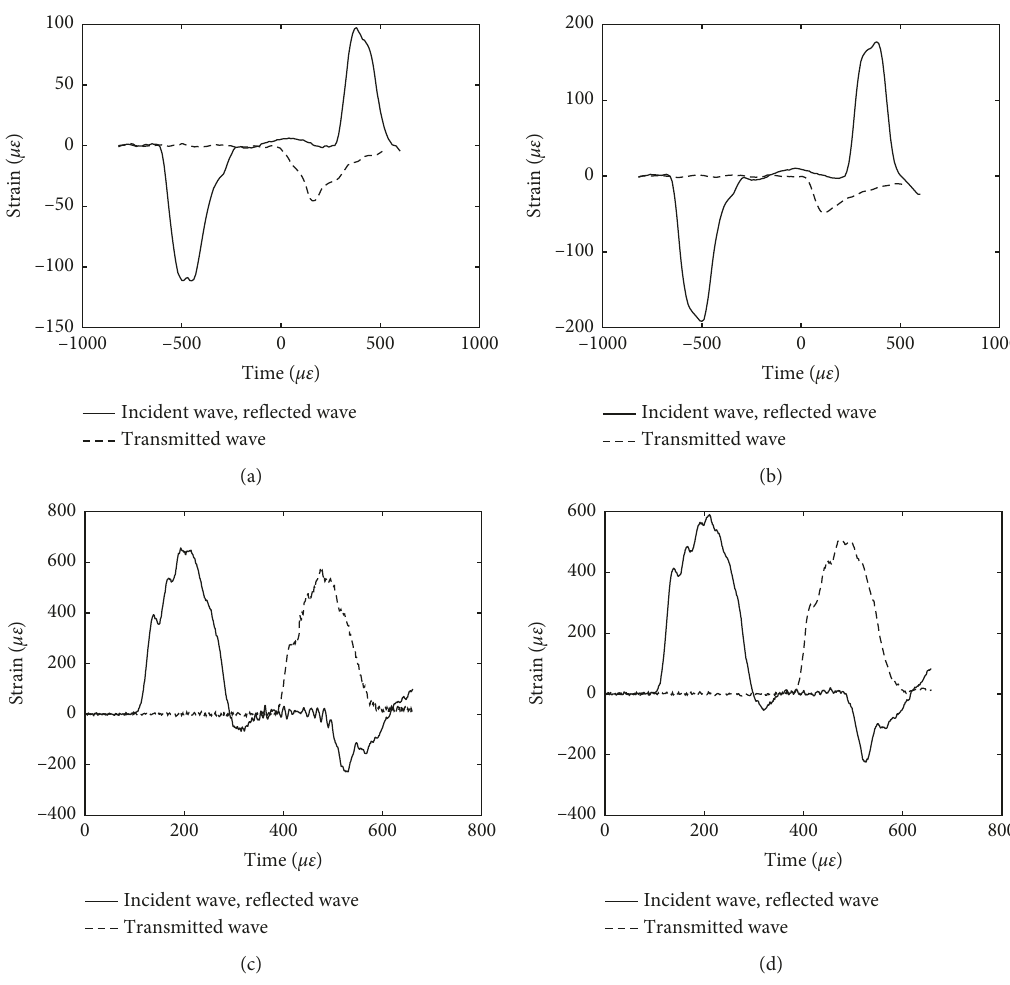
Figure 6: Stress waveform of marble and sandstone. (a) 92# dry sandstone. (b) 64# saturated sandstone. (c) Marble 1 (previous research results). (d) Marble 2 (previous research